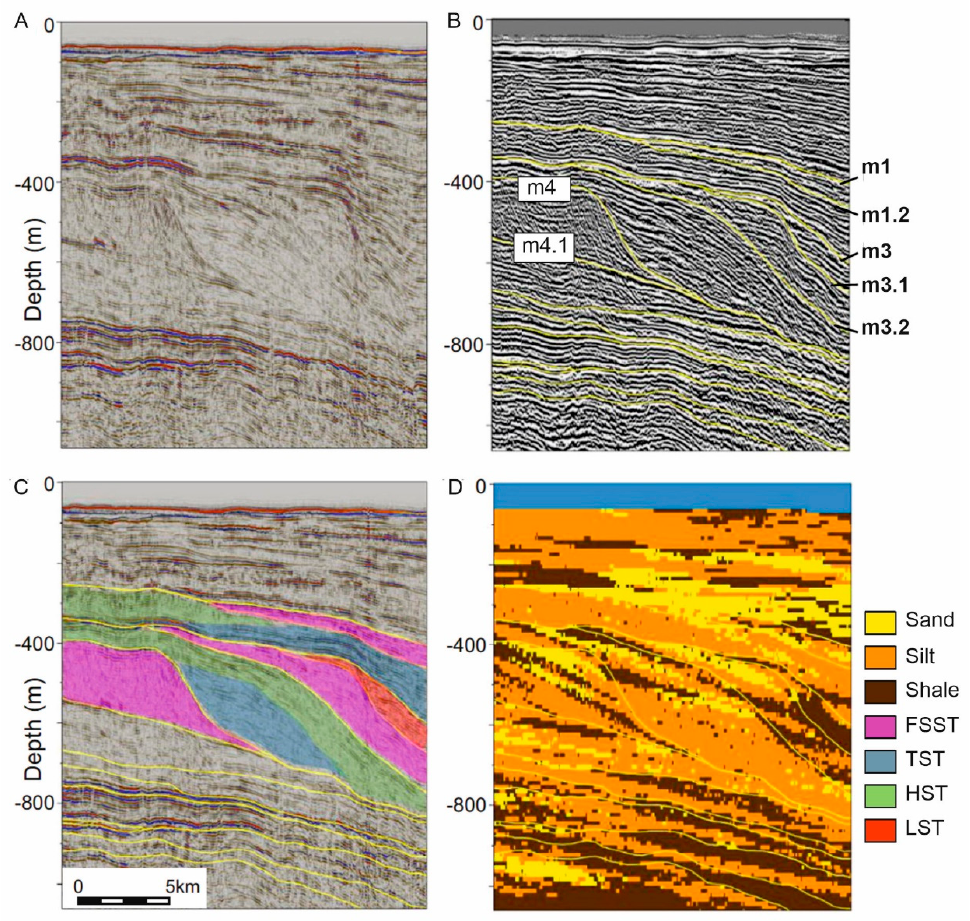
Figure 2. Example of use of seismic stratigraphic and attribute analysis for lithology / facies prediction in groundwater research (modified after Reference [70]). ( A ) Amplitude of a seismic line across the New Jersey continental shelf (see case study in Section 3.1.1 of this paper). ( B ) Cosine of phase attribute with major systems tracts boundaries (including sequence boundaries and transgressive surfaces / maximum regression surfaces) labelled to highlight the correlation of key seismic sequence stratigraphic relationships. ( C ) Original systems tracts interpretation by Reference [70] overlain on seismic data. ( D ) Stochastically generated facies distribution. FSST falling stage systems tract, TST transgressive systems tract, HST highstand systems tract, LST lowstand systems tract. Horizons m1 to m4.1 correspond to interpreted sequence boundaries used to constrain the shelf model (nomenclature after [71]).